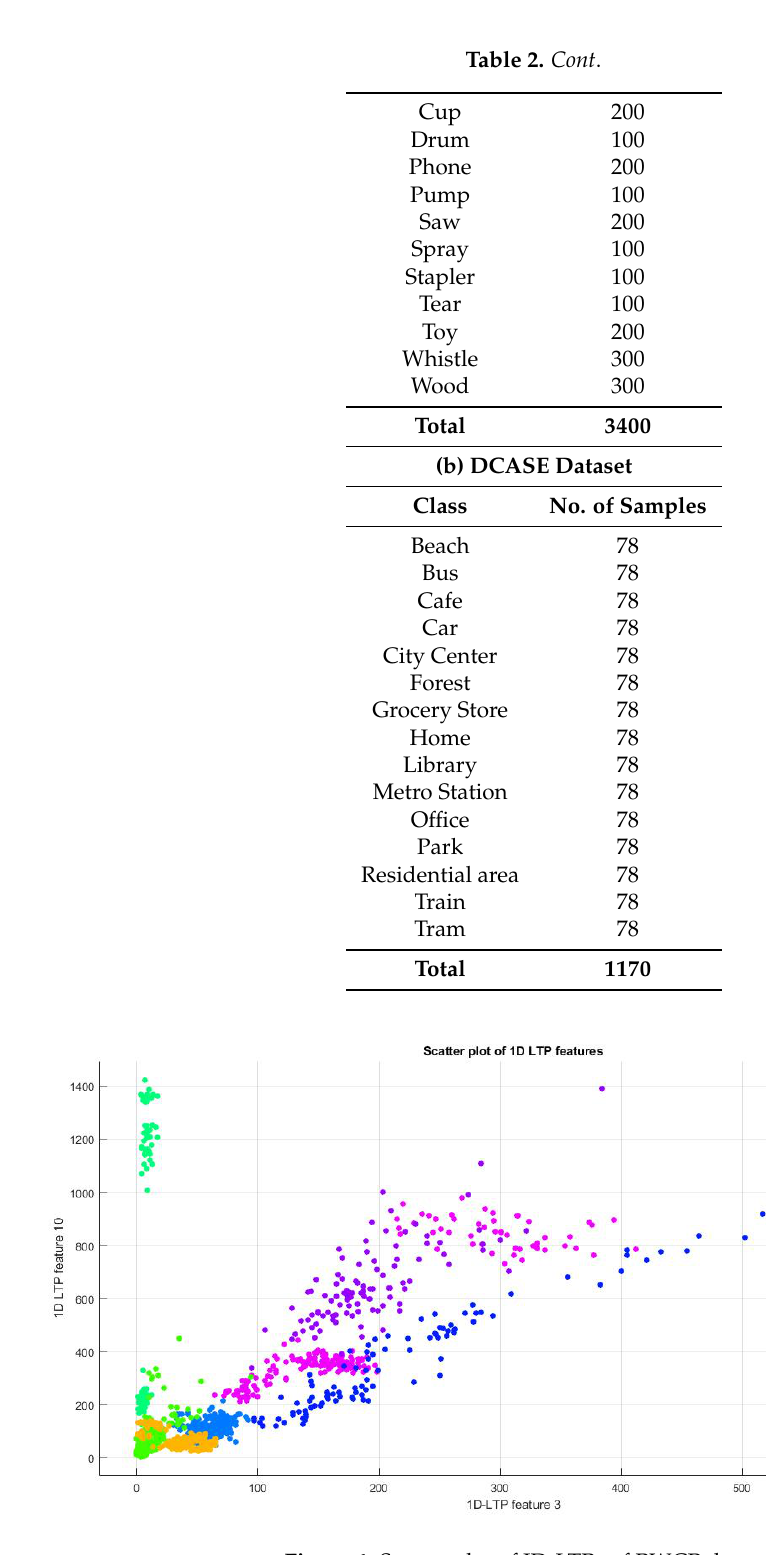
Figure 4. Scatter plot of ID-LTPs of RWCP